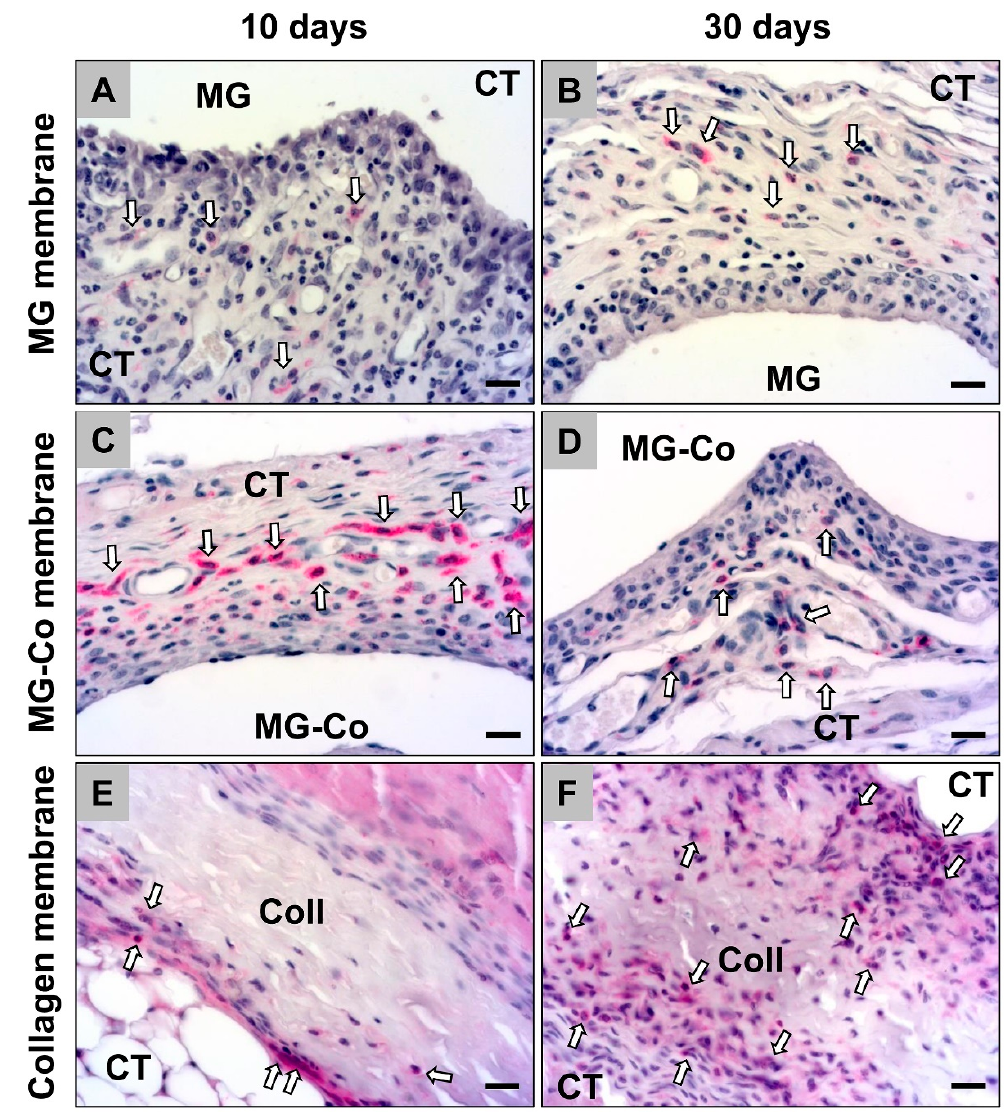
Figure 5. Exemplary histological images of pro-inflammatory (NF- κ B-positive) macrophages (white arrows) within the implant beds of the different membranes, i.e., the pure magnesium membrane (MG) ( A , B ), the coated magnesium membrane (MG-Co) ( C , D ) and the collagen membrane (Coll) ( E , F ). CT = connective tissue (NF- κ B immunostainings, 400 × magnification, scale bars = 10 μ m).